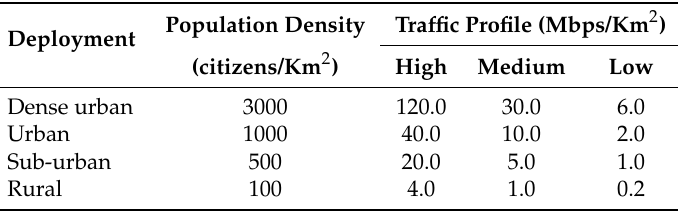
Table 1. EARTH traffic model for data traffic peaks in busy hours for different deployment